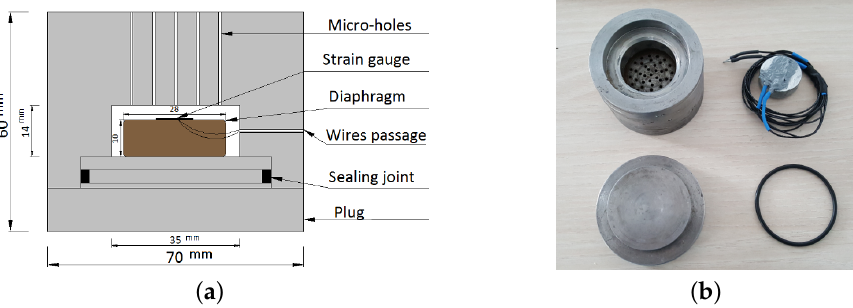
Figure 3. Aluminum sensor of hydrostatic type: ( a ) cross section of the collecting cap with the hydrostatic sensor dimension; and ( b ) picture of the cap and pressure